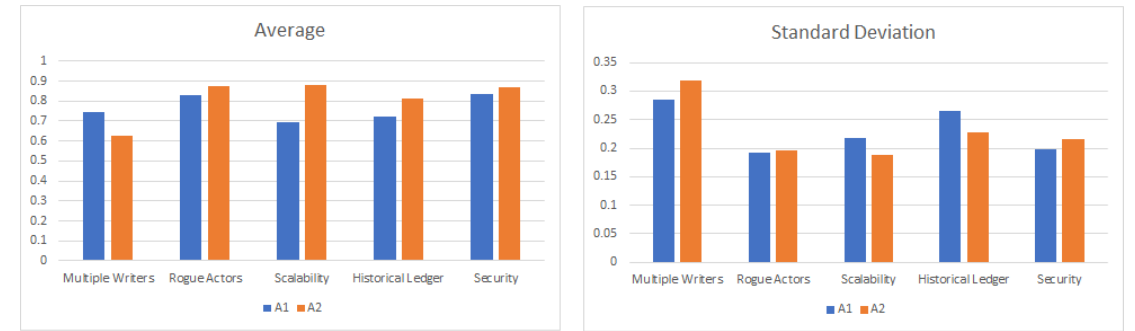
Figure 12. Average and standard deviation plot. Participant’s score for the five questions for applications A1 and